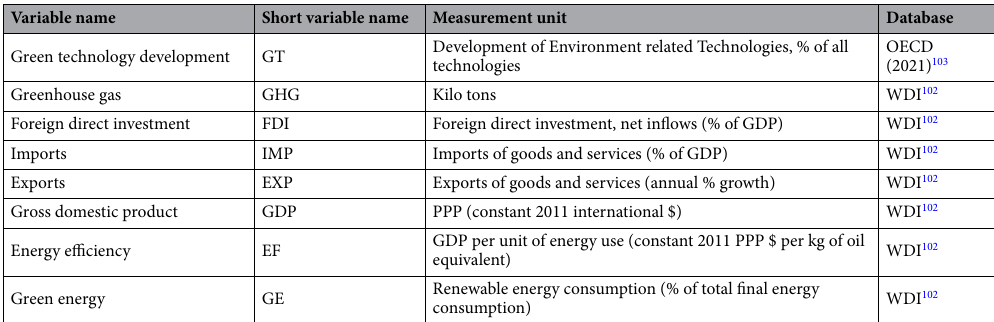
Table 1. Description of Variables.